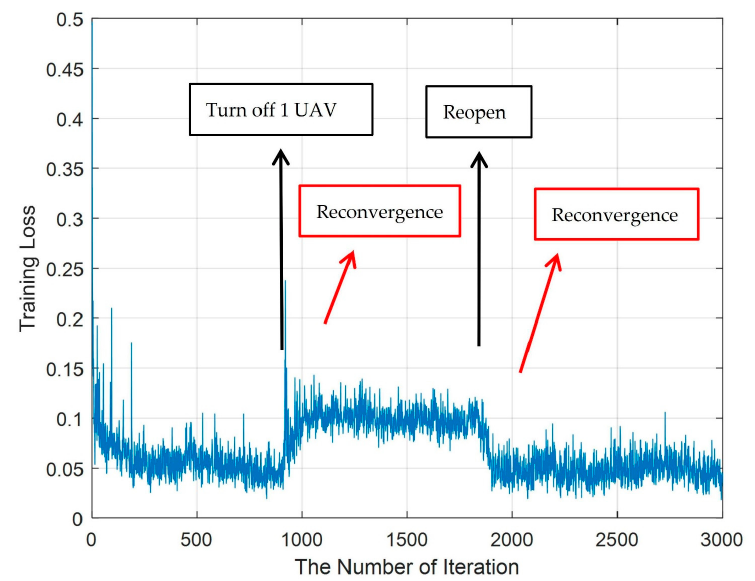
Figure 9. The convergence performance of the training loss when randomly turning one UAV off and then reopening